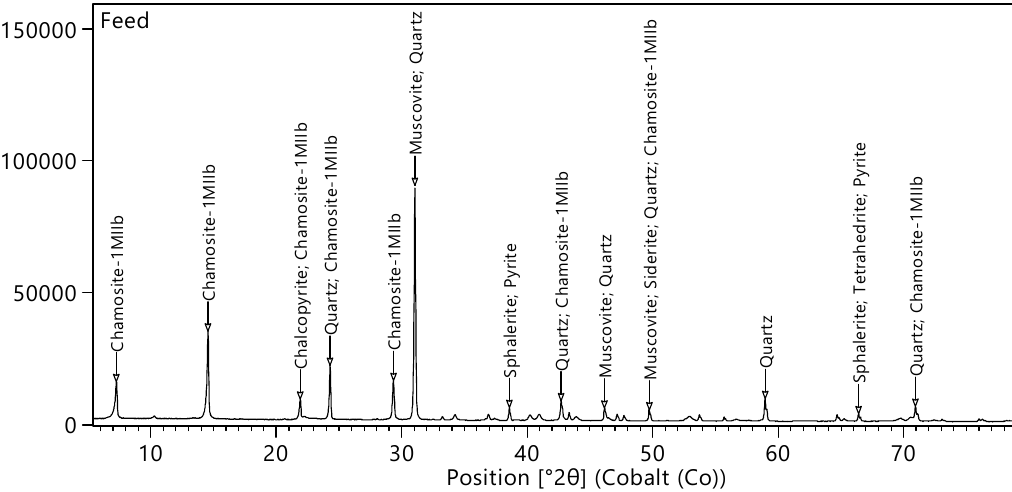
Figure 1. XRD scan of a flotation feed. The diffraction pattern of this feed is the representative scan as defined by the cluster analysis.